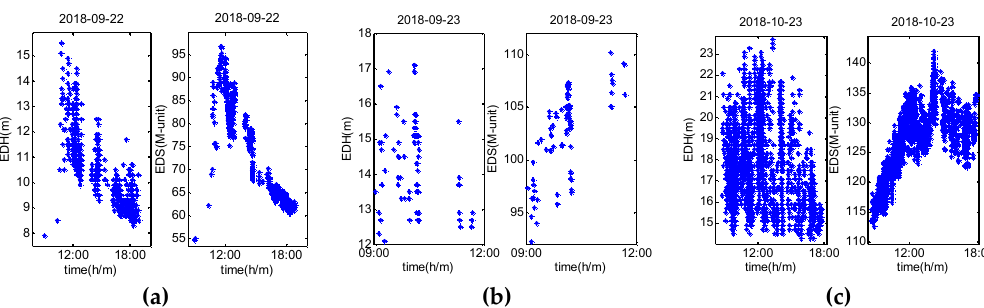
Figure 6. Time series of evaporation duct height (EDH) and evaporation duct strength (EDS) calculated by the Navy Postgraduate School (NPS) evaporation duct model. The data needed in the NPS model as input parameters were obtained by an automatic weather station (AWS). (a) , (b), and (c) show the evaporation duct on 22 September 2018, 23 September 2018, and 23 October 2018, respectively. In (a) , (b), and (c) , the left part is the evaporation duct height (EDH) vs. time, and the right part is the evaporation duct strength (EDS) vs. time.